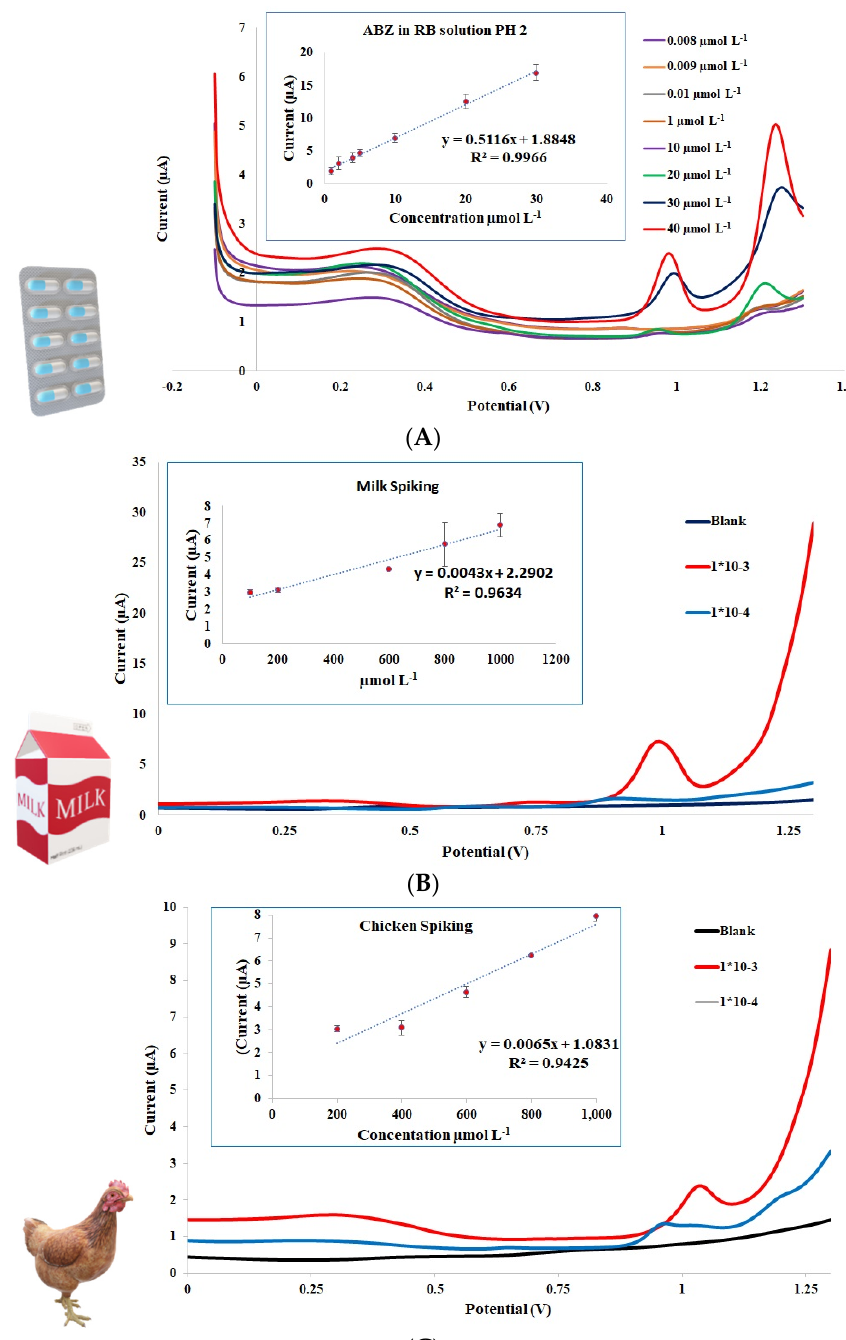
Figure 7. Application of Pt-Pd-modified GCE for ABZ detection. The plot of ABZ oxidation peak current versus its concentration in ( A ) BR buffer (pH 2); ( B ) in milk (pH 2); ( C ) in ground chicken (pH 2).